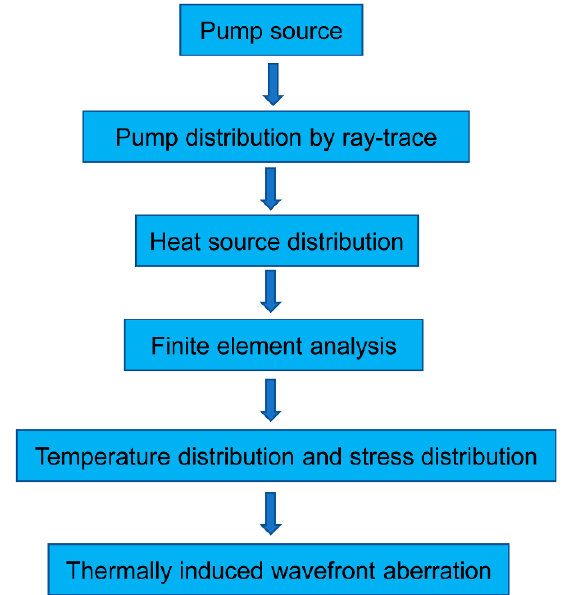
Figure 4. Thermal simulation flow chart of the laser amplifier.